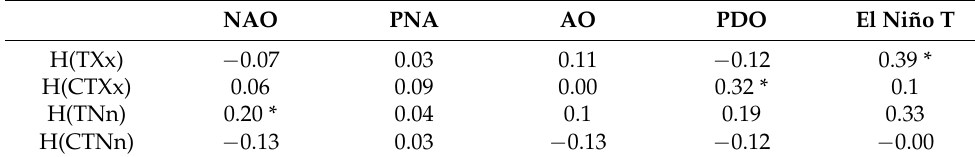
Table 3. Correlation matrix of Atmospheric Circulation Index and H values.